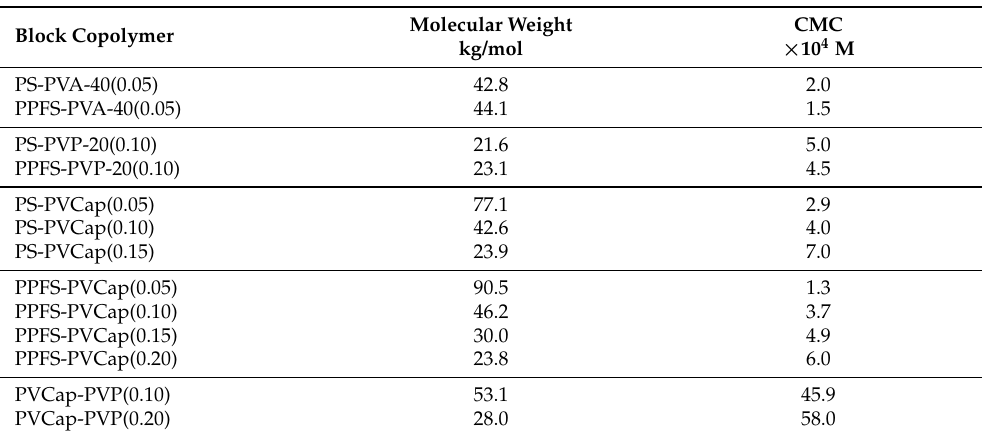
Table 2. Critical micelle concentration (CMC) for all amphiphilic block copolymer gas hydrate inhibitors examined by Rajput et al.